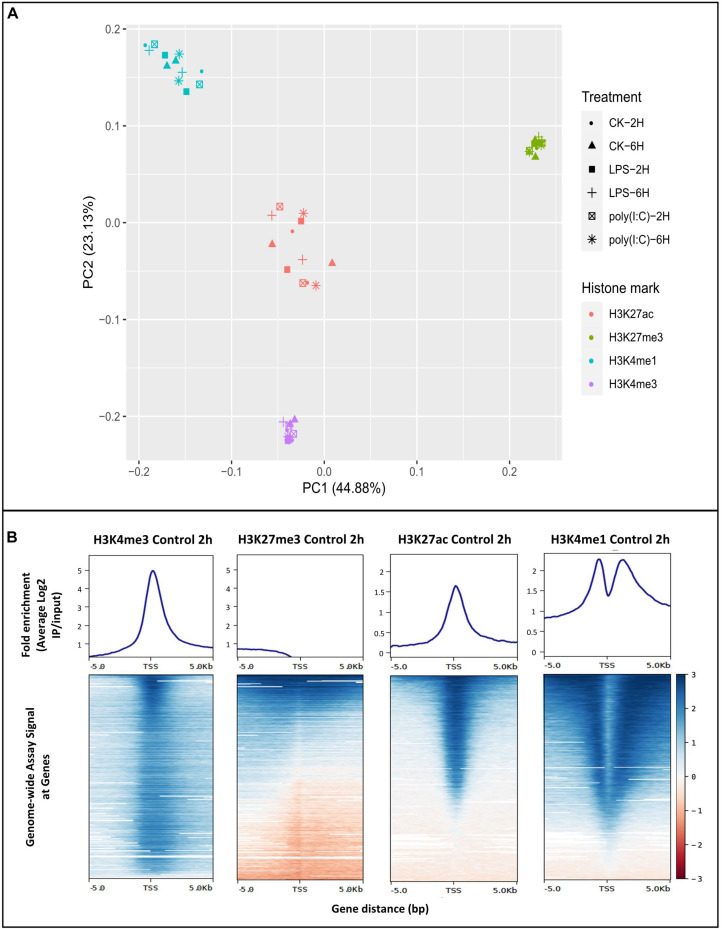
Chromatin histone modification analysis of porcine alveolar macrophages. (A) Principal component analysis plot of histone ChIP-seq samples. (B) The average genome wide histone fold enrichment (average log2 IP/input) near TSS (± 5.0 Kb) was calculated for each individual histone mark. Non-stimulated alveolar macrophages at 2 h were displayed in the figure as representative.